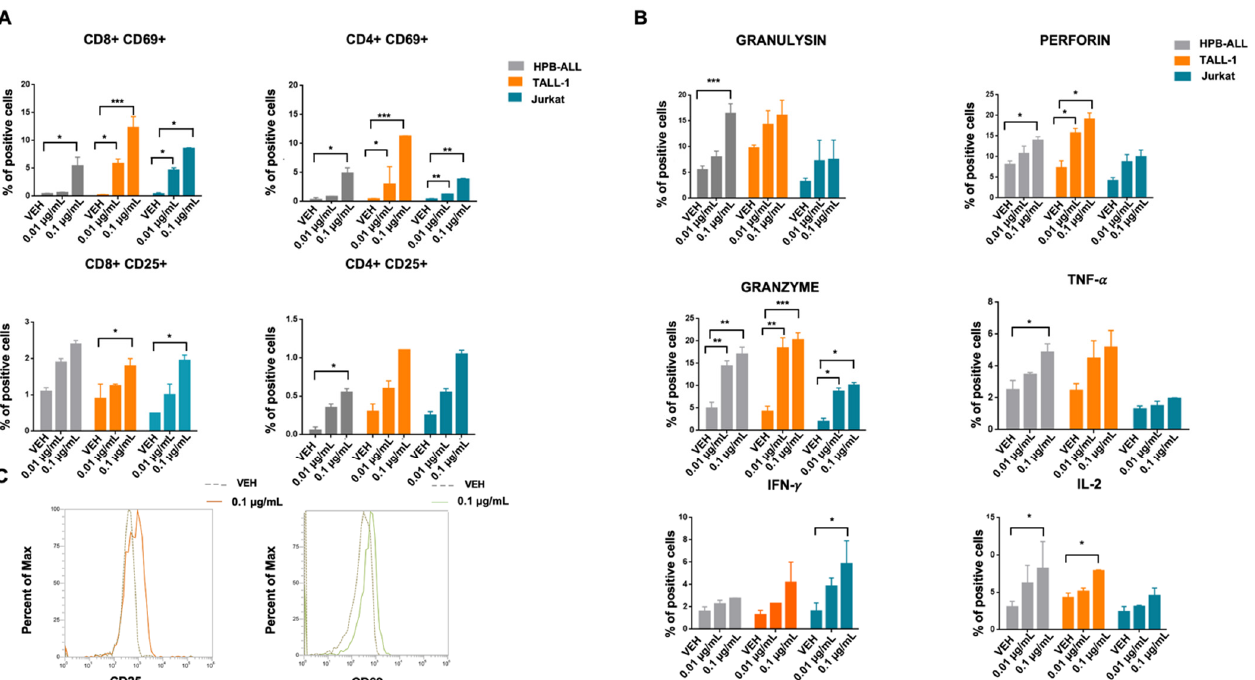
Figure 3. CD1a x CD3 ε BTCE in vitro functional activity. ( A ) Activation markers (CD69, CD25) on CD8-CD4 T lymphocytes of vehicle or co-cultured with T-ALL cells at a 10:1 E:T ratio in the presence of vehicle or increasing concentration of CD1a x CD3 ε BTCE. ( B ) Cytotoxic enzyme production (perforin, granzyme, and granulysin), cytokine release (IFN-y, TNF-a and IL-2) on T lymphocytes co-cultured with T-ALL cells in the presence of vehicle, or increasing concentration of CD1a x CD3 ε BTCE. ( C ) Representative FACS data of CD25 and CD69 on cell membrane of PBMCs co-cultured with T-ALL cells at a 10:1 E:T ratio in the presence of vehicle or increasing concentration of CD1a x CD3 ε BTCE; * p < 0.05, ** p < 0.01, *** p < 0.001.